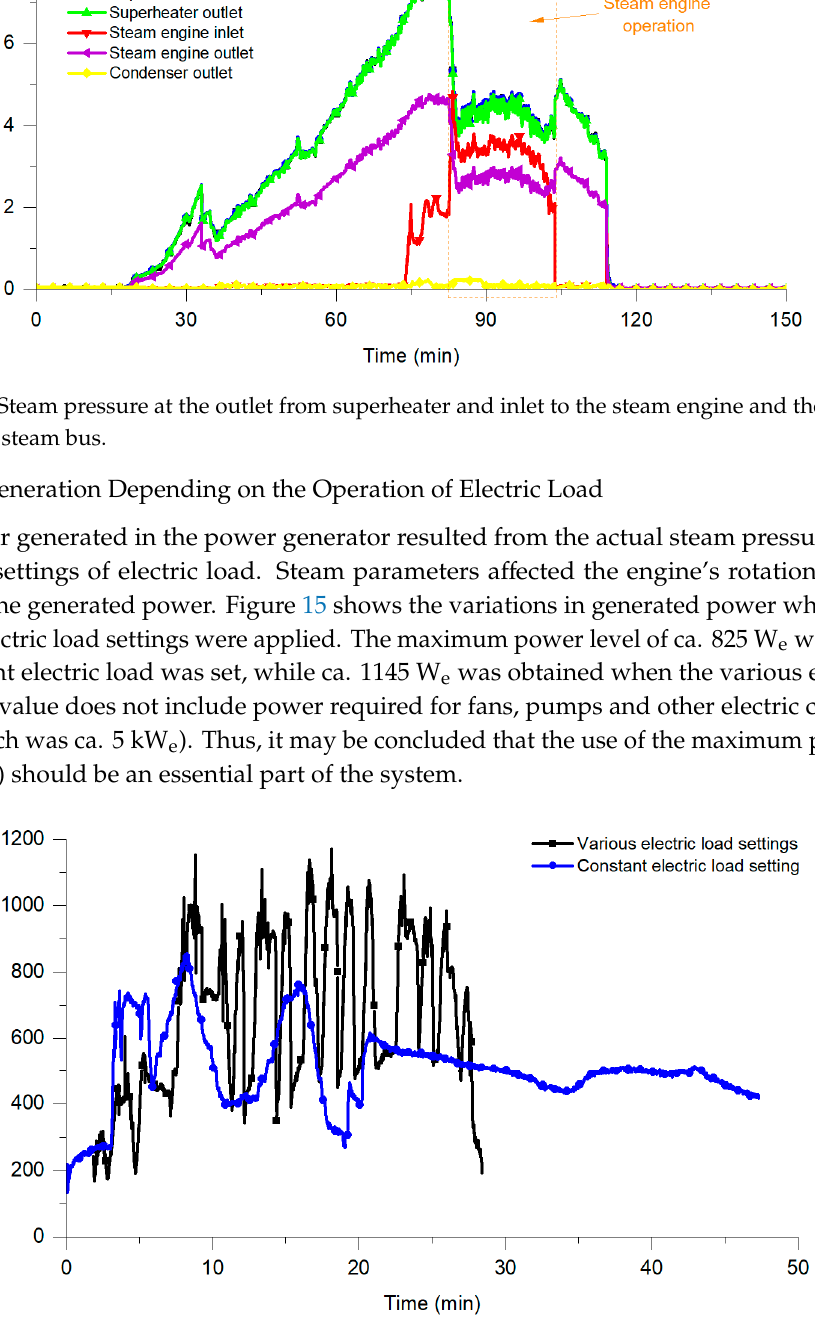
Figure 15. The relationship between generated power, steam pressure and steam flow.